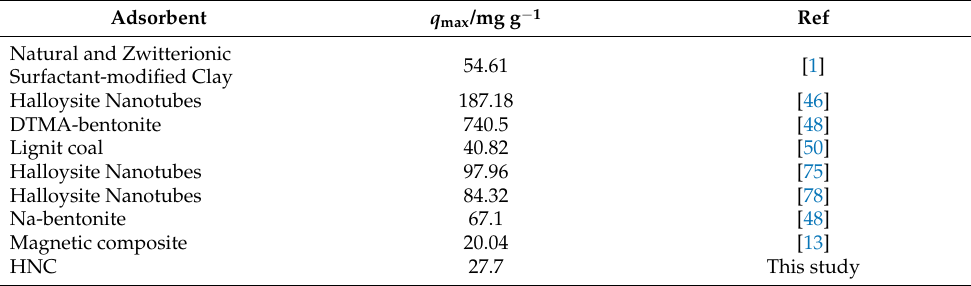
Table 3. Comparison of HNC adsorption capacities with various adsorbents.